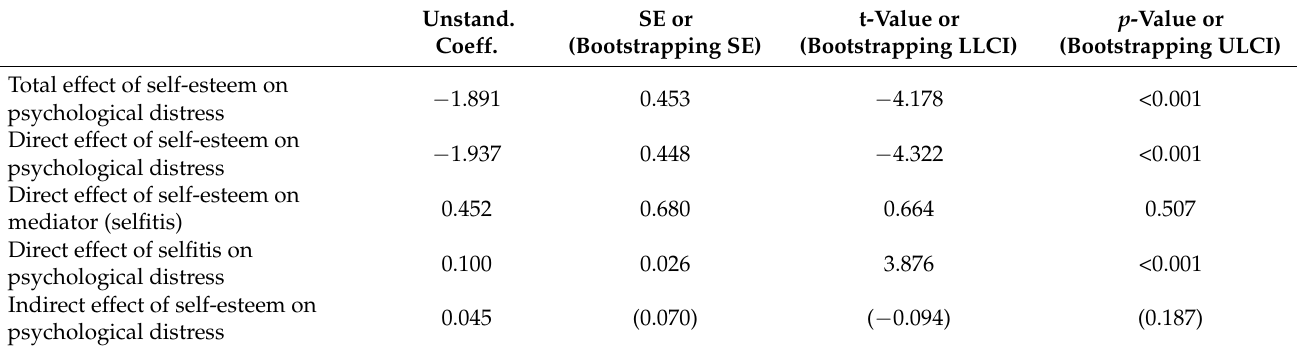
Table 6. Models of the effect of self-esteem on psychological distress with selfitis as the mediator. Unstand. SE Coeff.